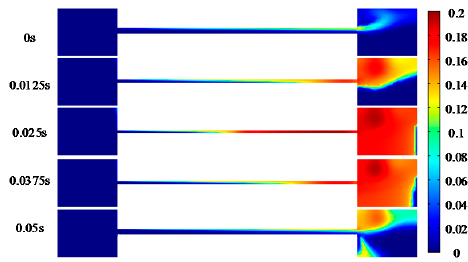
Figure 5. Gas void fraction during the different machining stages with tool vibration.